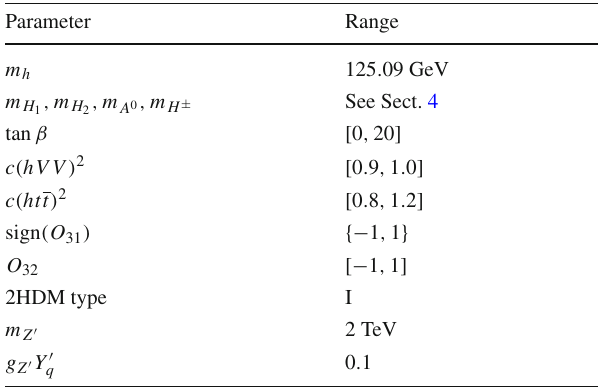
Table 2 List of common input parameters for the parameter space scan